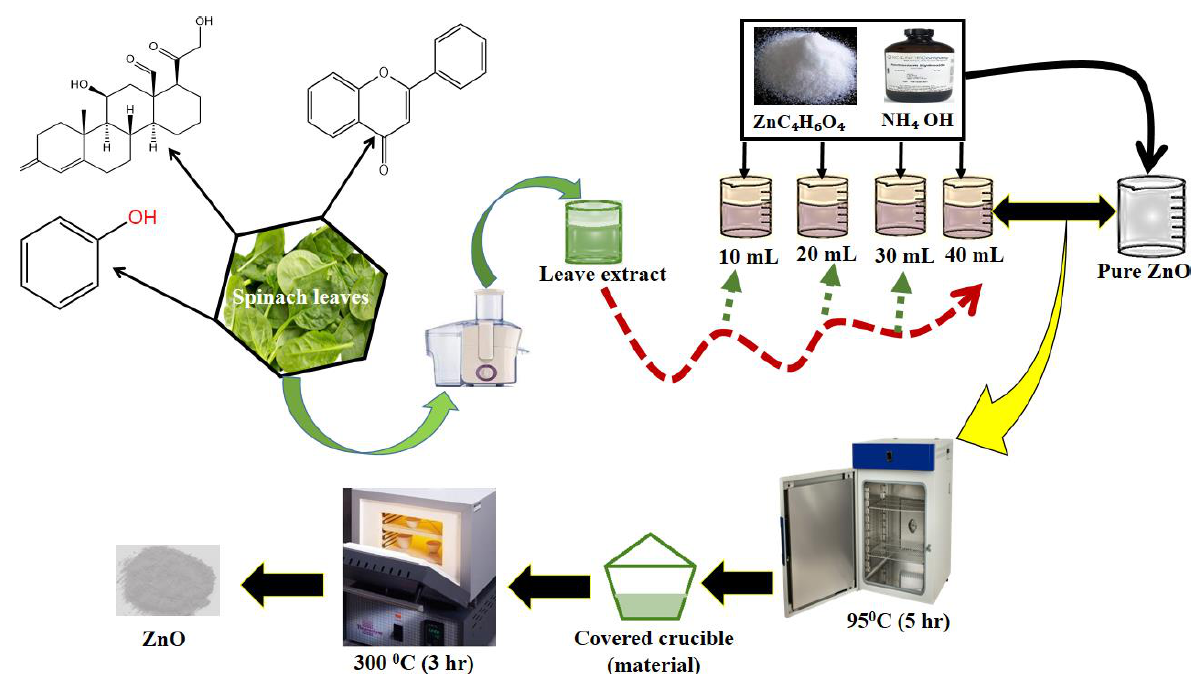
Scheme 1. Material synthesis illustration of as-synthesized ZnO samples treated with different amounts of leafy extract of S. oleracea . Table 4. Samples with